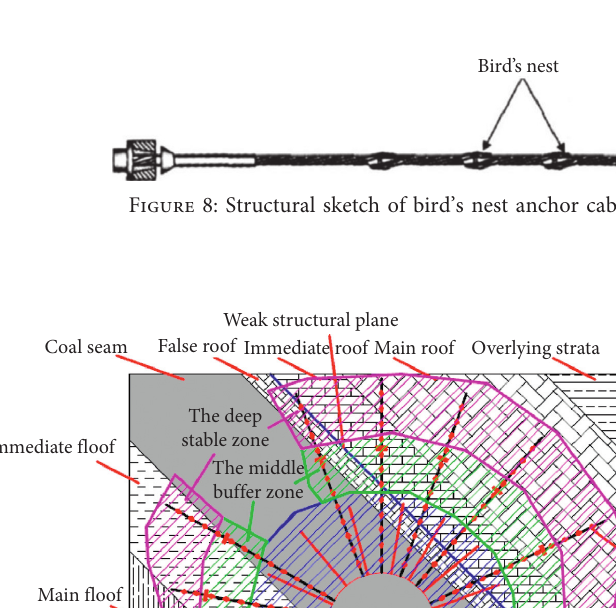
Figure 7: Structure diagram of yield bolts (cables).